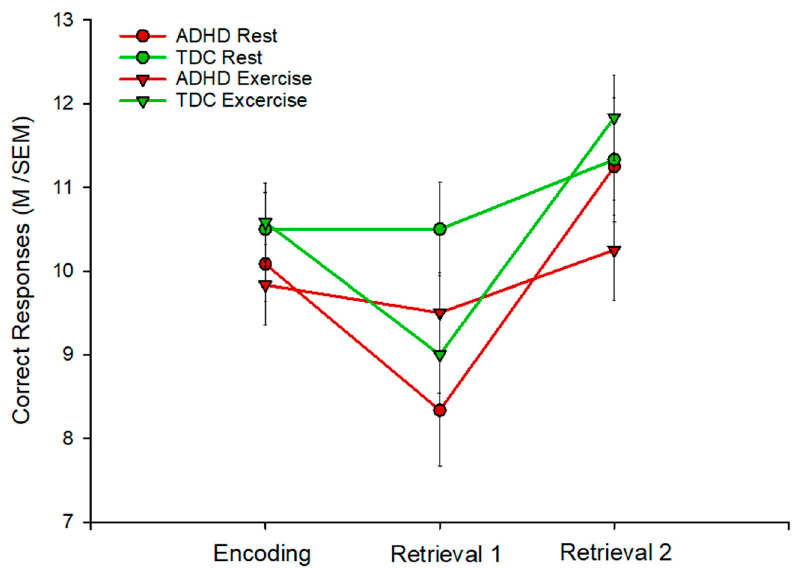
Figure 2. Results of the declarative memory task: mean (M) and standard error of mean (SEM) number of correctly recalled card pairs in children with attention deficit hyperactivity disorder (ADHD) and typically developing children (TDC) during the EXERCISE (red) and REST (green) conditions. Table 2. Sleep data: means (M) and standard error of mean (SEM) of total sleep time (TST); sleep